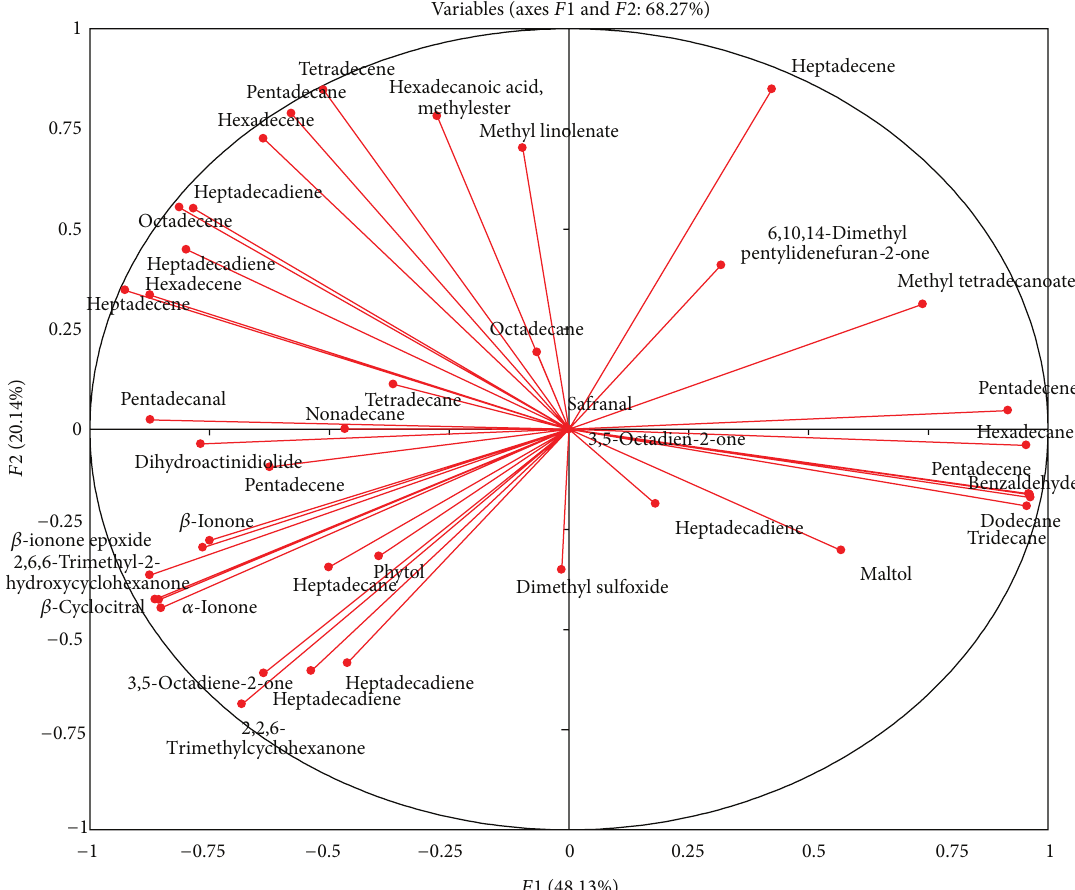
Figure 4: Correlation circle of volatile compounds from different green algae samples. The profiling was carried out based on 41 peaks and detected corresponding peak area ratios. Samples were independently analyzed in triplicate. The data was analyzed by PCA using XL-STAT